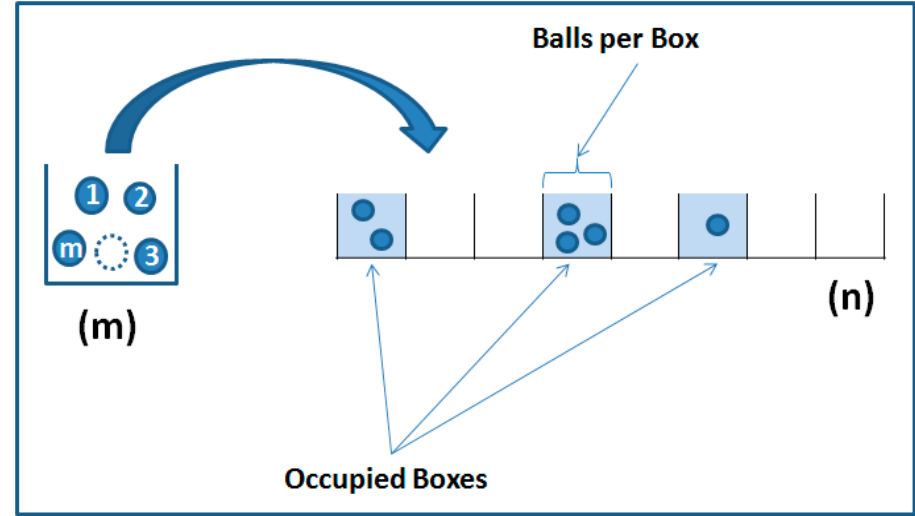
Figure 2. The occupancy problem modeling of the beacon distribution.